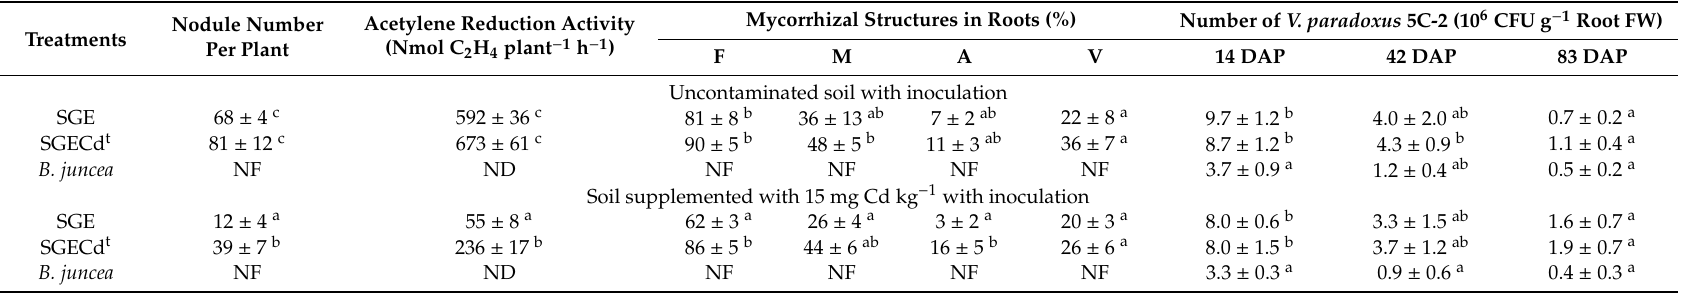
Table 1. Parameters of symbiotic activities of the plants inoculated with a microbial consortium and grown in uncontaminated or Cd-supplemented soil.